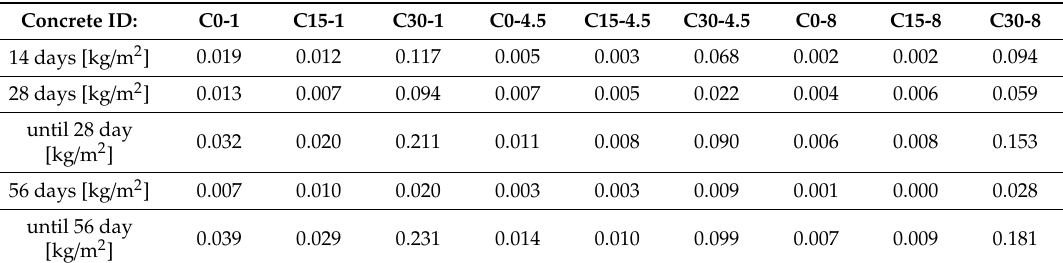
Table 6. Results of scaling